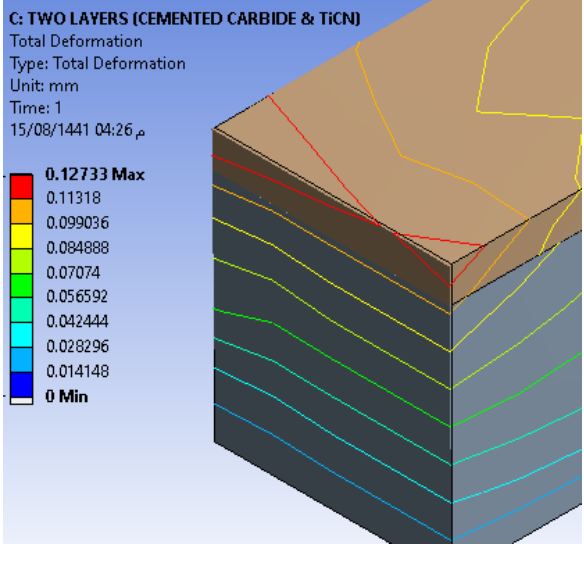
(a) 1 mm of TiCN, total deformation of 0.12733 mm (b) 1.5 mm of TiCN, total deformation of 0.12733 mm